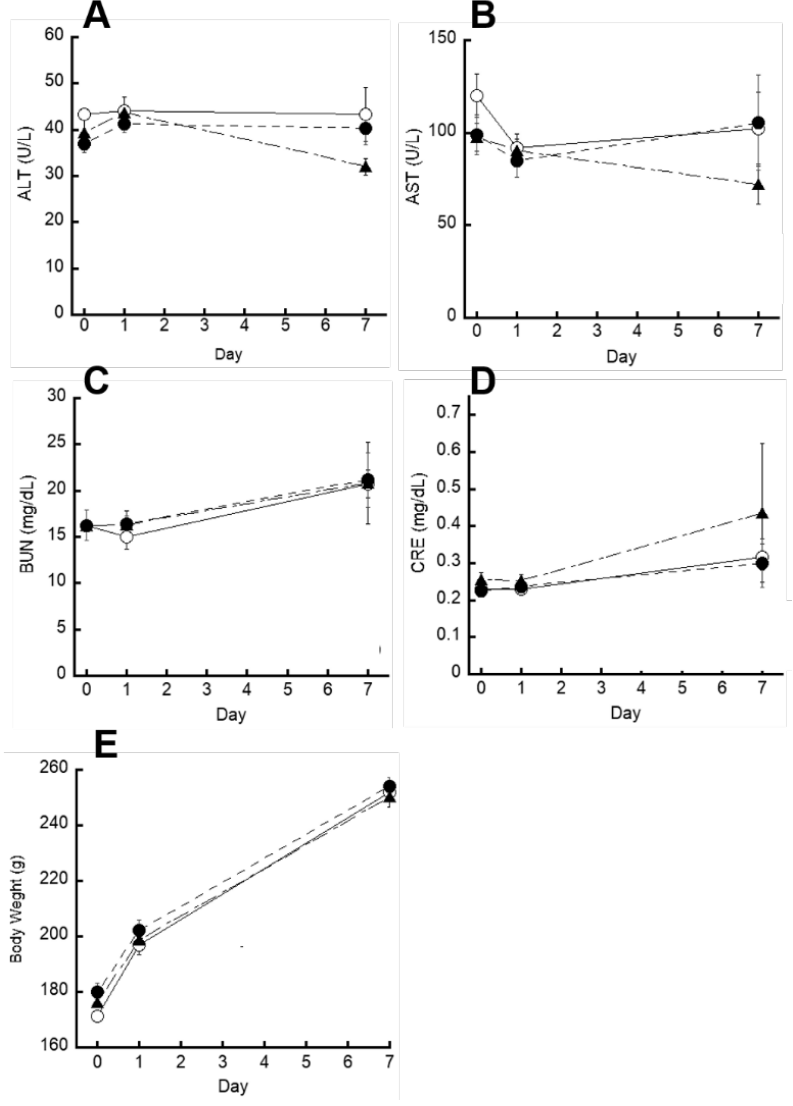
Figure 6. Acute toxicity of PMETAC- co -PAMPAA(HpD). The comparison of plasma ( A ) ALT, ( B ) AST, ( C ) BUN and ( D ) CRE between test group and control group after intraperitoneal injection of PBS (open circle), HpD (closed triangle), PMETAC- co -PAMPAA(HpD) (closed circle). ALT: alanine aminotransferase, AST: aspartate aminotransferase, BUN: blood urea nitrogen, CRE: creatinine. ( E ) Changes in body weight after intraperitoneal injection of PBS (open circle), HpD (closed triangle), PMETAC- co -PAMPAA(HpD) (closed circle). Data are shown as mean ± SEM ( n = 3).